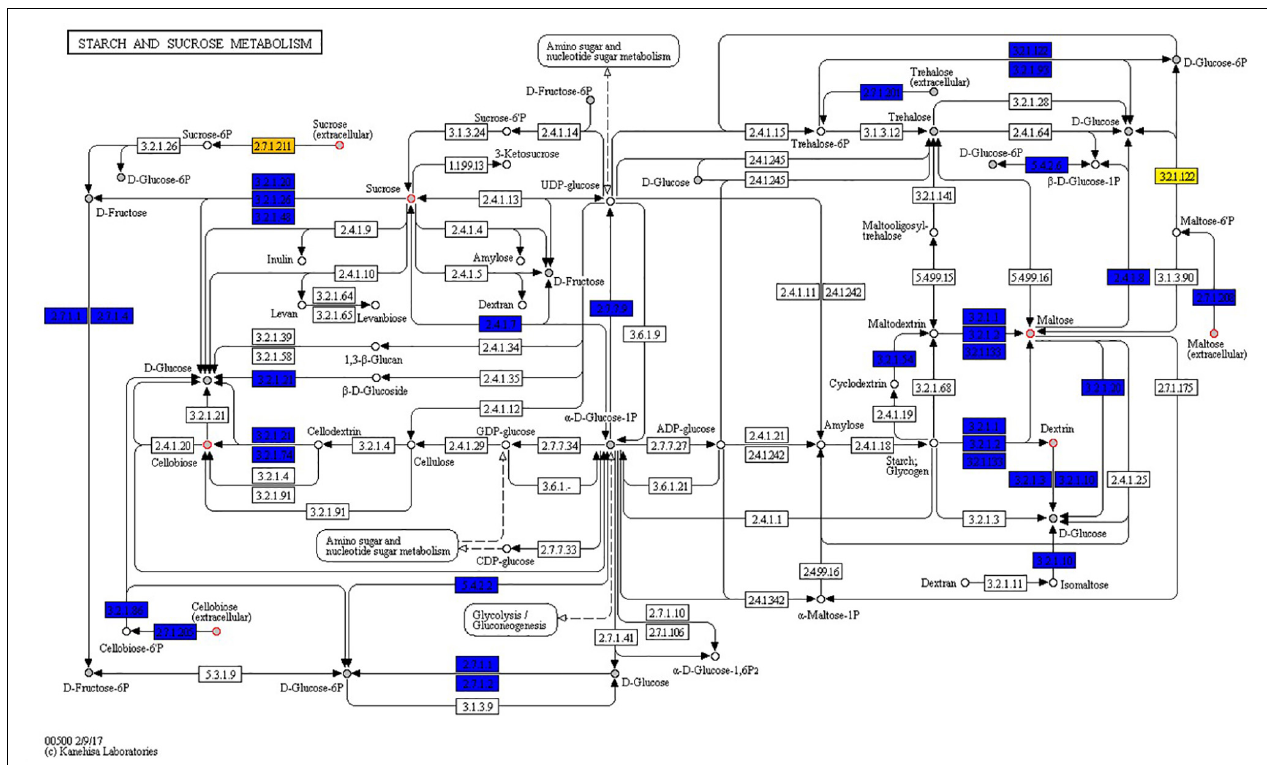
FIGURE 7 | Strains show high phenotypic variability despite high genomic and metabolic pathway conservations. Starch and sucrose metabolism map: boxes represent reactions while circles represent compounds. Core reactions are colored blue, variable reactions are colored orange or yellow; compounds present in PM plates are filled with gray. Red circles around compounds highlight those compounds for which at least one strain has an AV difference with another strain equal or higher than 2